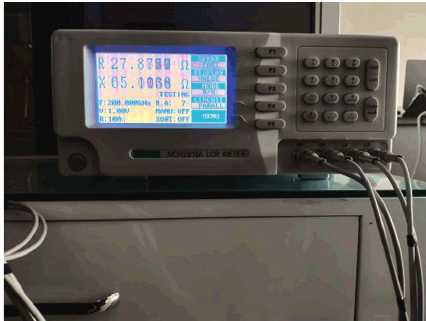
Figure 4: The MCH2816 A digital AC bridge.